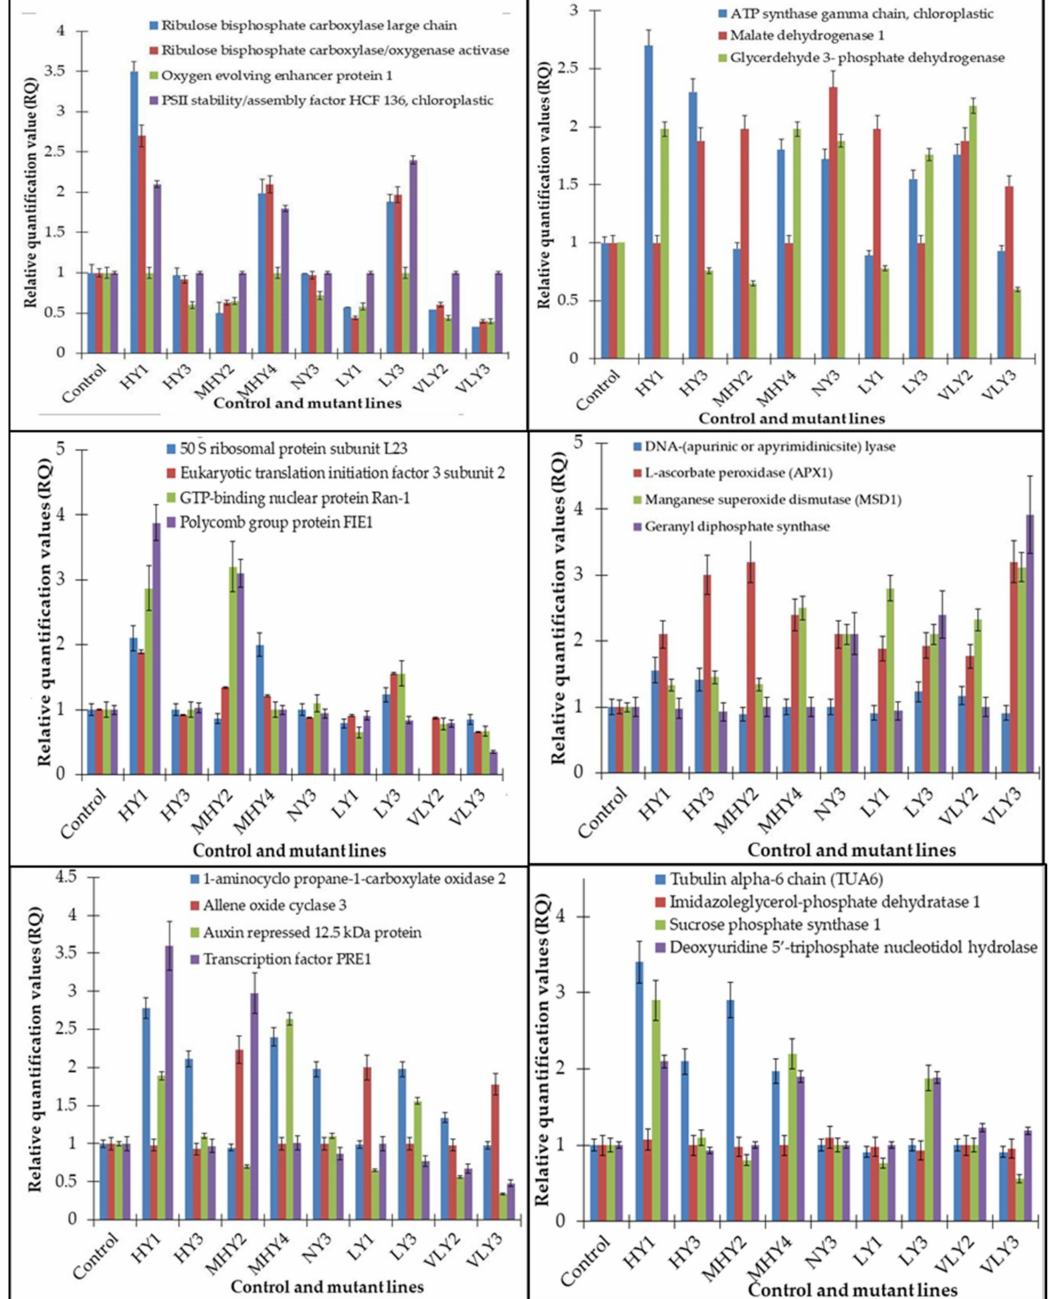
Figure 3. Expression analyses of the genes encoding di ff erentially expressed proteins of the control and mutant lines of Nigella sativa L., as determined by quantitative RT-PCR. Values are the mean of three replicates (n = 3). Bars show the standard error. The normalization of the gene expression of mutant plants was done by setting the gene expression of the control as